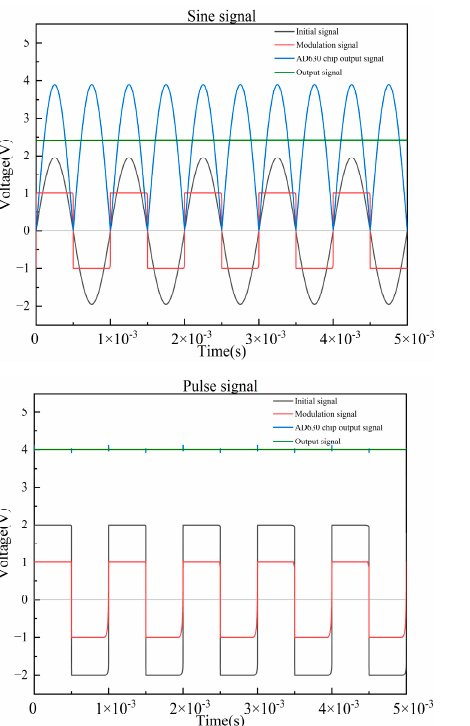
Figure 6. Working principle of the conditioning circuit.